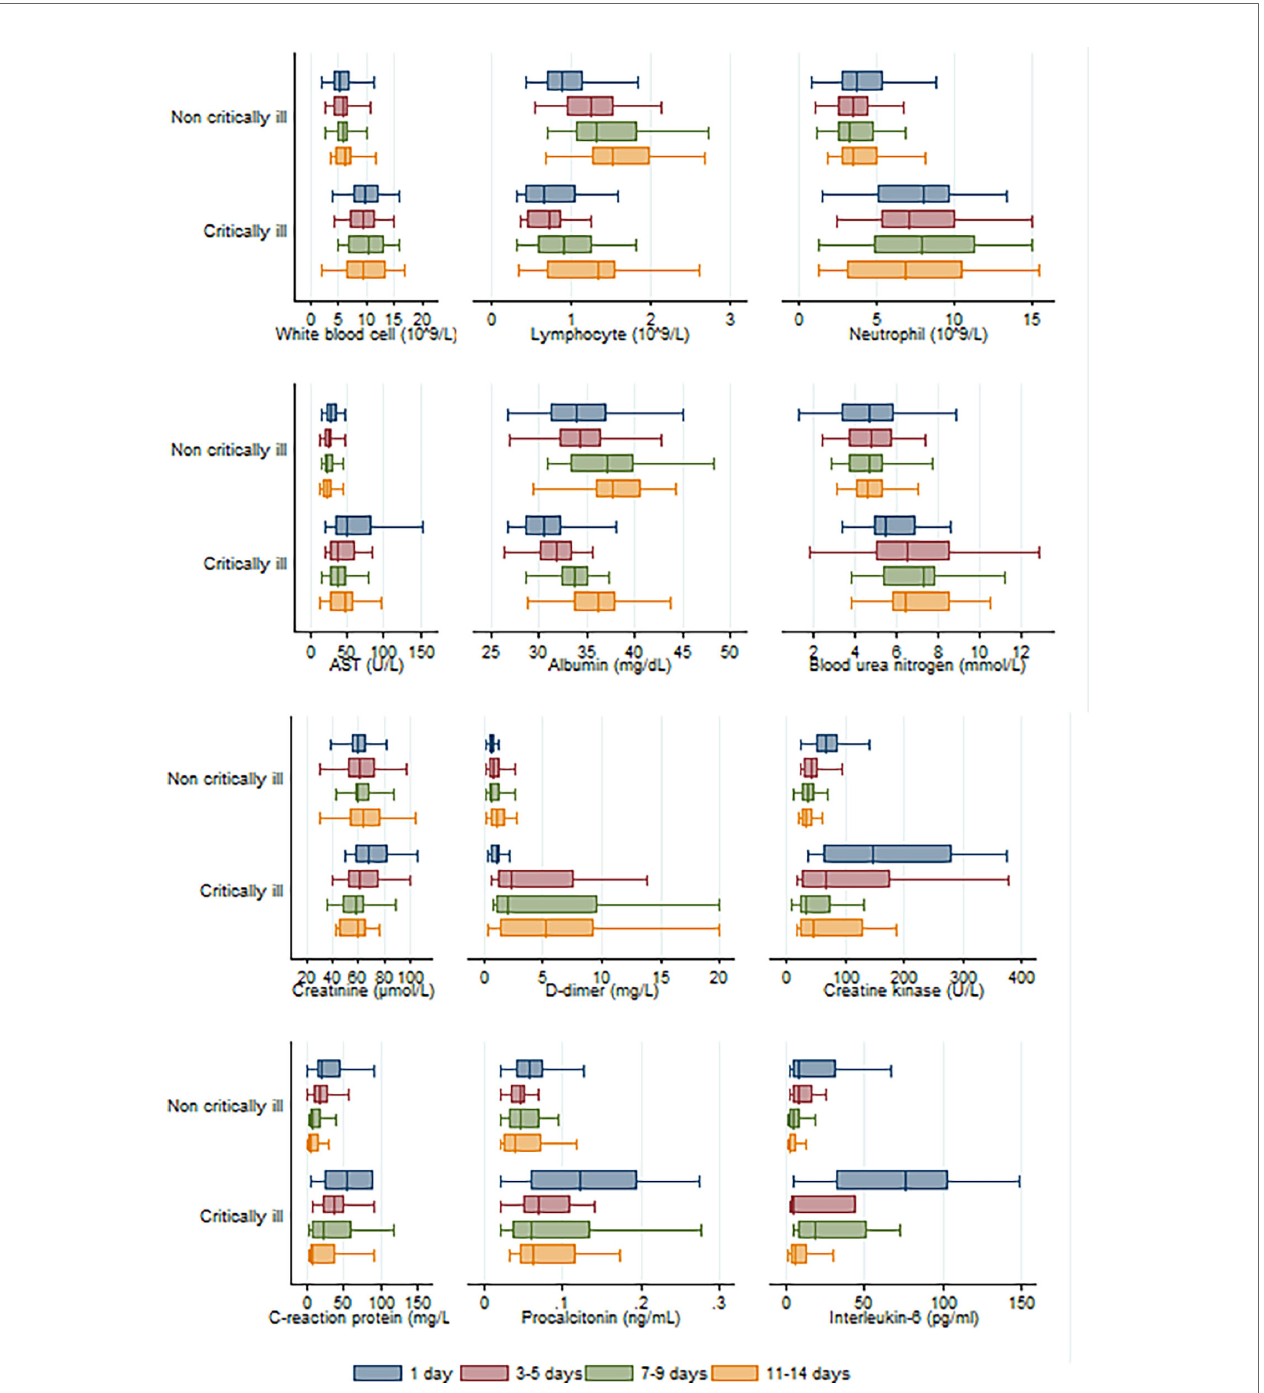
FIGURE 2 | Longitudinal analysis of twelve laboratory parameters altered during the hospitalization in critically and non-critically ill